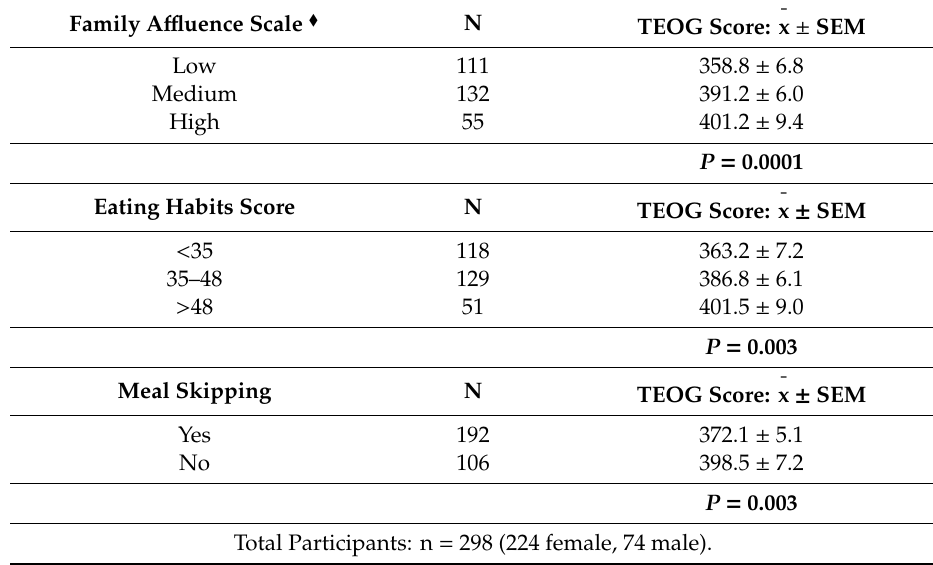
Table 4. Assessment of students (cid:48) success via TEOG scores relative to FAS, EHS and meal skipping status. Family A ffl uence Scale